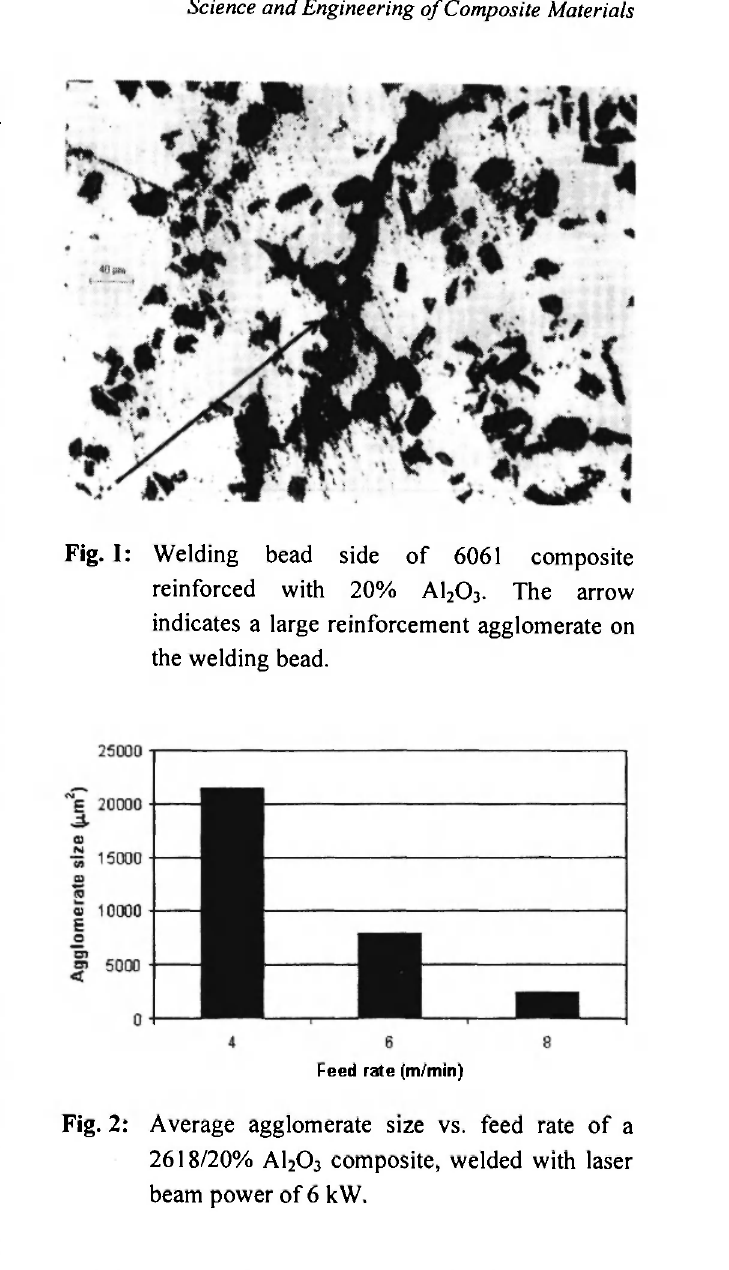
Fig. 2: Average agglomerate size vs. feed rate of a 2618/20% Al 2 0 3 composite, welded with laser beam power of 6